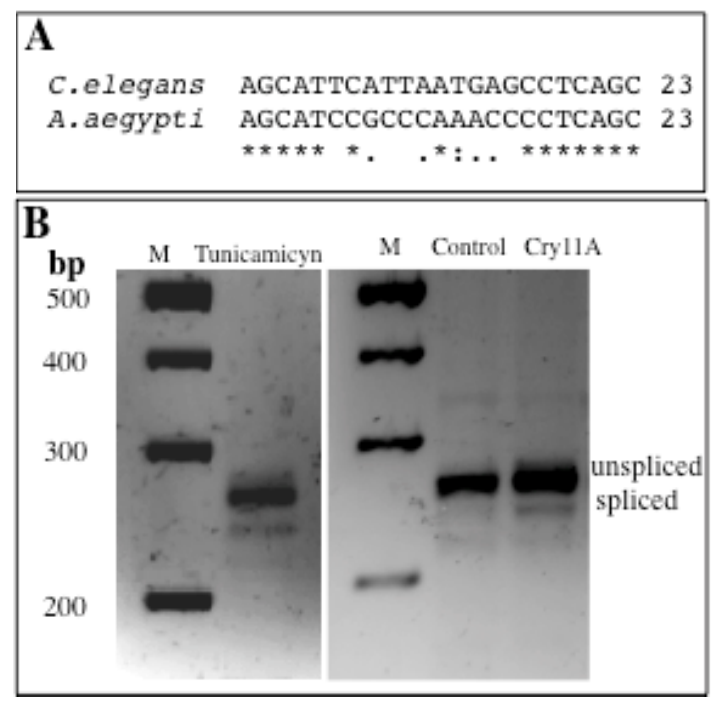
Figure 1. The splicing of xbp -1 by the IRE-1 kinase/endonuclease is induced as response to Cry11Aa intoxication in Aedes aegypti . ( A ) Alignment of the sequence of the 23 nucleotides that constitutes the intron of xbp -1 that is cleaved in C. elegans and the corresponding sequence in A. aegypti ; ( B ) Splicing of xbp -1 is induced in A. aegypti by tunicamicyn or after 2 h of intoxication with Cry11Aa toxin at LC 50 . M, nucleotide size markers. Control, were larvae feed without toxin.